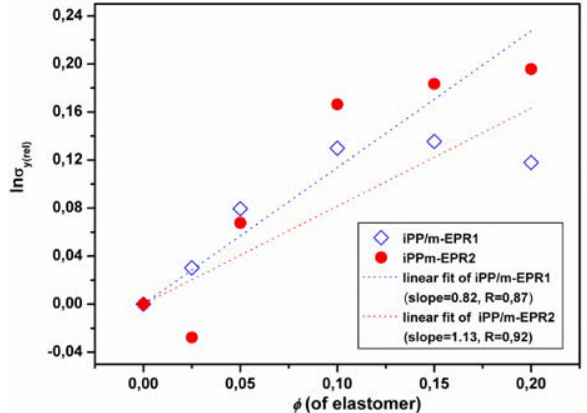
Figure 8. Presentation of calculated ln σ rel values in dependence on elastomer content